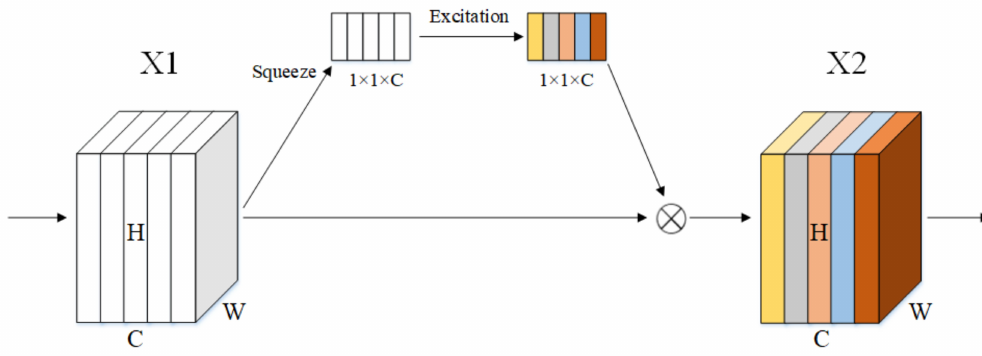
Figure 4. SENet structural diagram.